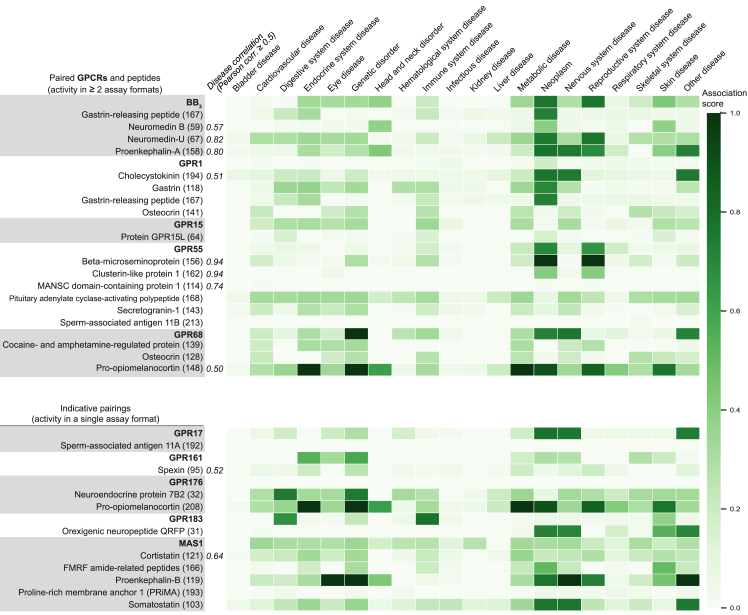
Disease Associations for Novel Peptide-Receptor PairsDiseases associated with paired receptors and peptide precursors from https://www.opentargets.org. Open Targets presents associations with therapeutic areas by agglomerating data; e.g., genome-wide associations, genetic variants, expression and animal models. Disease association scores between 0 and 1 (color intensity) summarize the strength of evidence. For precursors with disease correlation similar to the associated receptor target, the Pearson correlation value is indicated. UniProt names for precursors are shown, with peptide library designation in parentheses (Table S4).